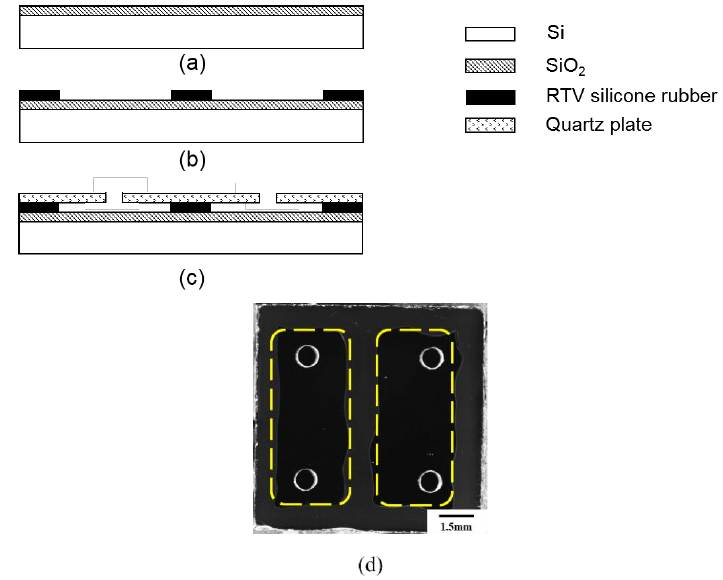
Figure 6. The fabricating processes and the planform of the PCR reaction chamber. ( a ) Thermal oxidation for SiO 2 layer. ( b ) Patterning of the RTV silicone rubber. ( c ) Quartz plate attaching. ( d ) Two chambers on a reaction chip (circled by yellow dotted line); each chamber had an inlet and an outlet. The volume of each chamber was 10 μL.